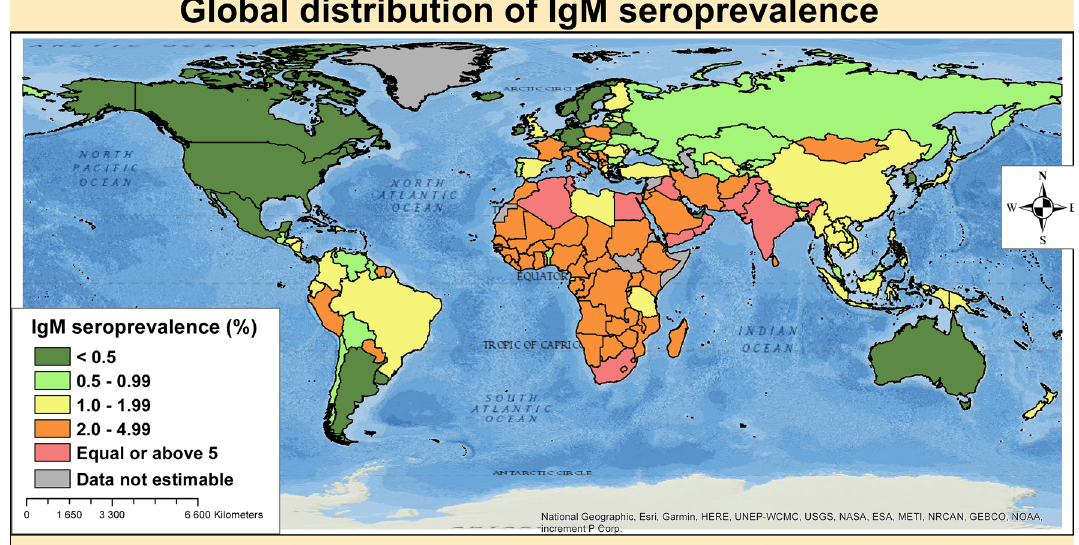
Figure 1. Global distribution of Toxoplasma gondii immunoglobulins M seroprevalence in pregnant